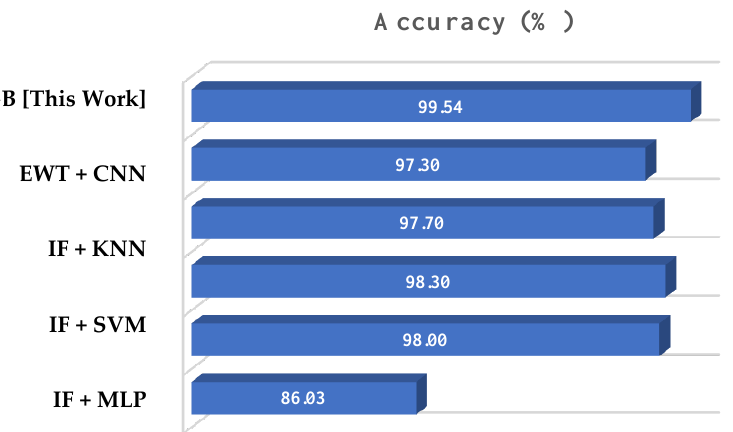
Figure 13. Comparison of the classification accuracy of designed model with existing works: (i) EWT + CNN [58], (ii) IF + KNN [57], (iii) IF + SVM [57], (iv) IF + MLP [57], and (v) WPD + SVM-PSO [55].